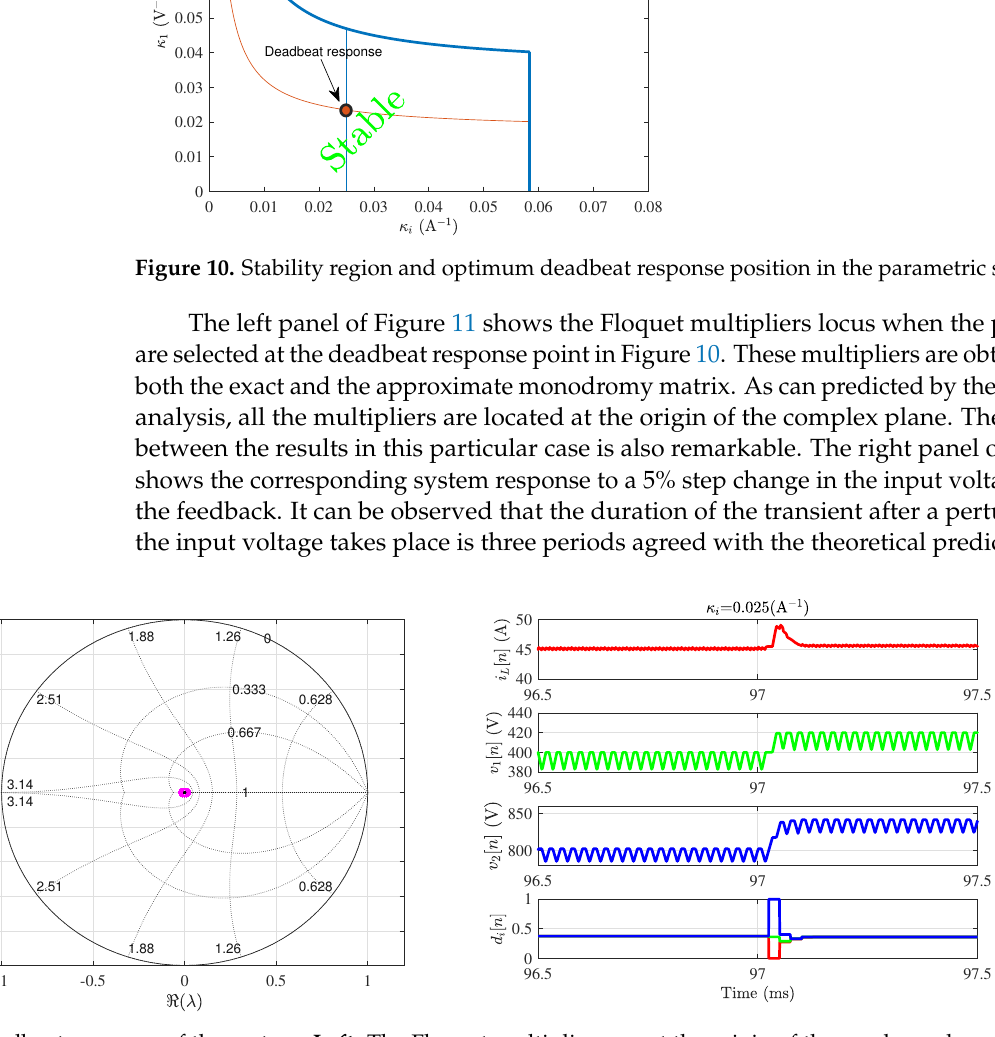
Figure 11. Deadbeat response of the system. Left : The Floquet multipliers are at the origin of the comlpex plane. Right : The system settling time is three switching